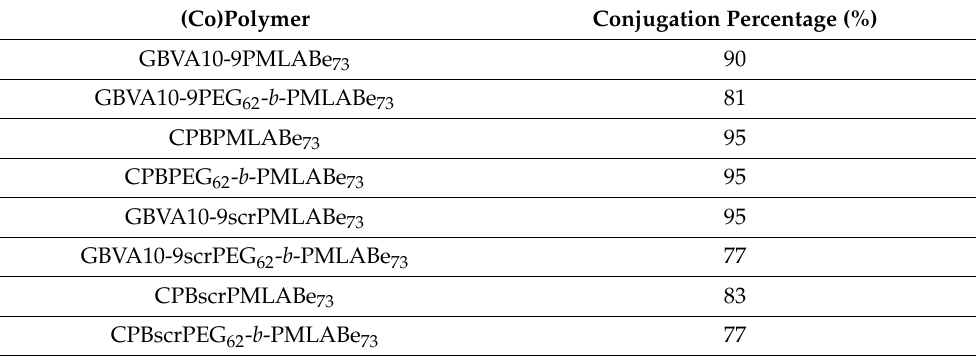
Table 4. Conjugation percentage of each peptide on each maleimide